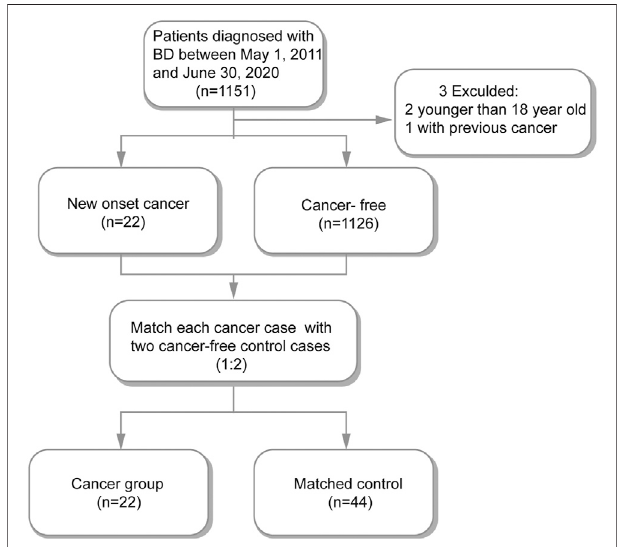
FIGURE 1 | Flow chart of the study design.